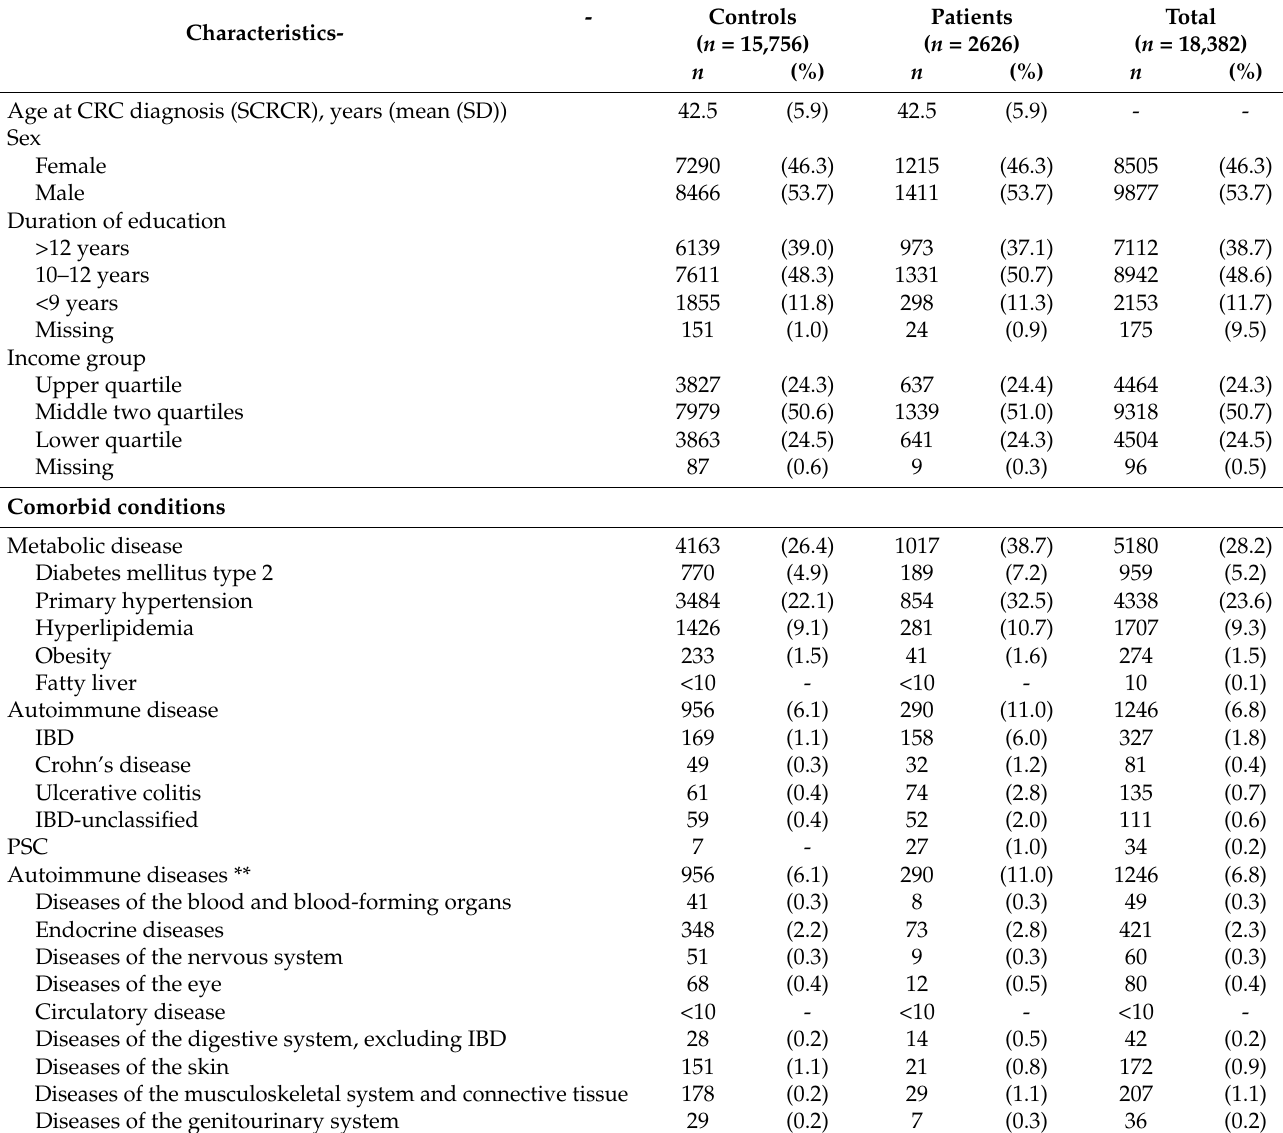
Table 1. Descriptive statistics of Swedish early-onset colorectal cancer * patients and controls, matched for birth year, sex, and county, between 2007 and